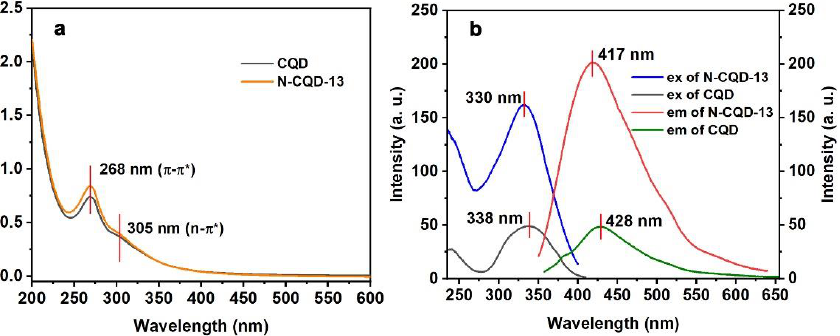
Figure 4. UV-Vis absorption spectra ( a ) and fluorescence excitation and emission spectra ( b ) of CQD (80 mg/L) and N-CQD-13 (80 mg/L) in aqueous